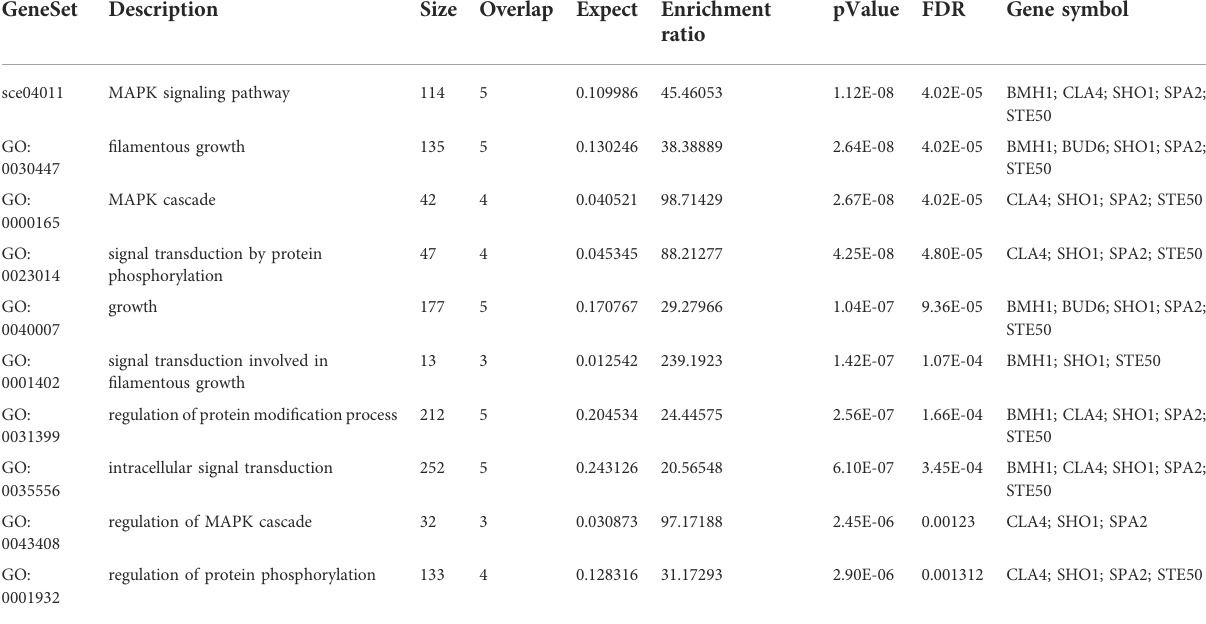
TABLE 4 KEGG enrichment analysis for enriched gene